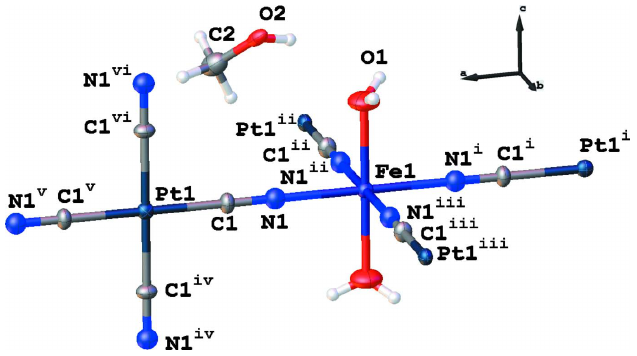
Figure 1 A fragment of the crystal structure of the title compound showing the atom-labelling scheme. Displacement ellipsoids are drawn at the 50% probability level. [Symmetry codes: (i) 1 (cid:3) x , 1 (cid:3) y , + z ; (ii) y , 1 (cid:3) x , + z ; (iii) 1 (cid:3) y , x , z ; (iv) 1 (cid:3) z , y , (cid:3) 1 + x ; (v) 2 (cid:3) x , 1 (cid:3) y , z ; (vi) 1 + z , y , 1 (cid:3) x ; (vii) x , 1 (cid:3) y , (cid:3) z ].